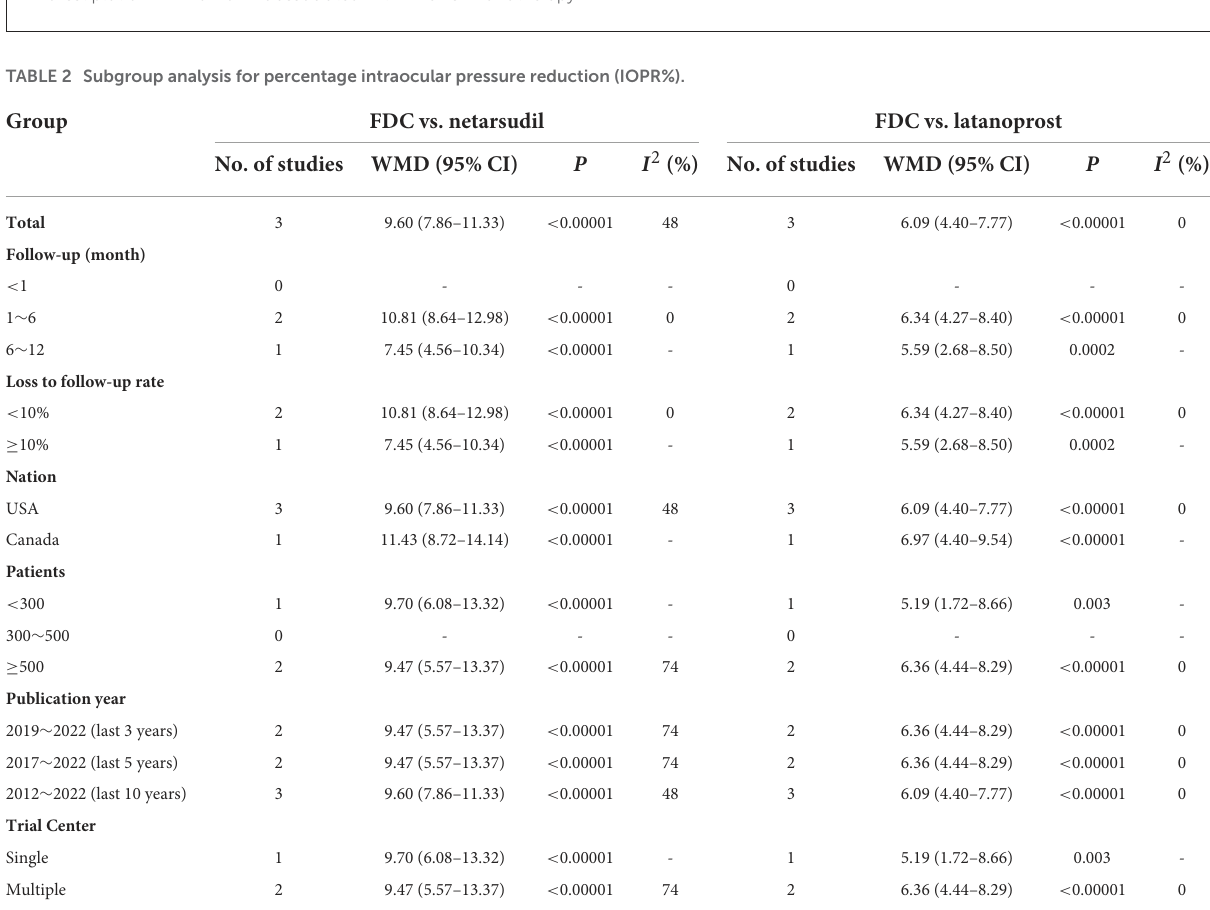
FIGURE4 Forest plot of WMD of IOPR% associated with FDC vs. monotherapy.